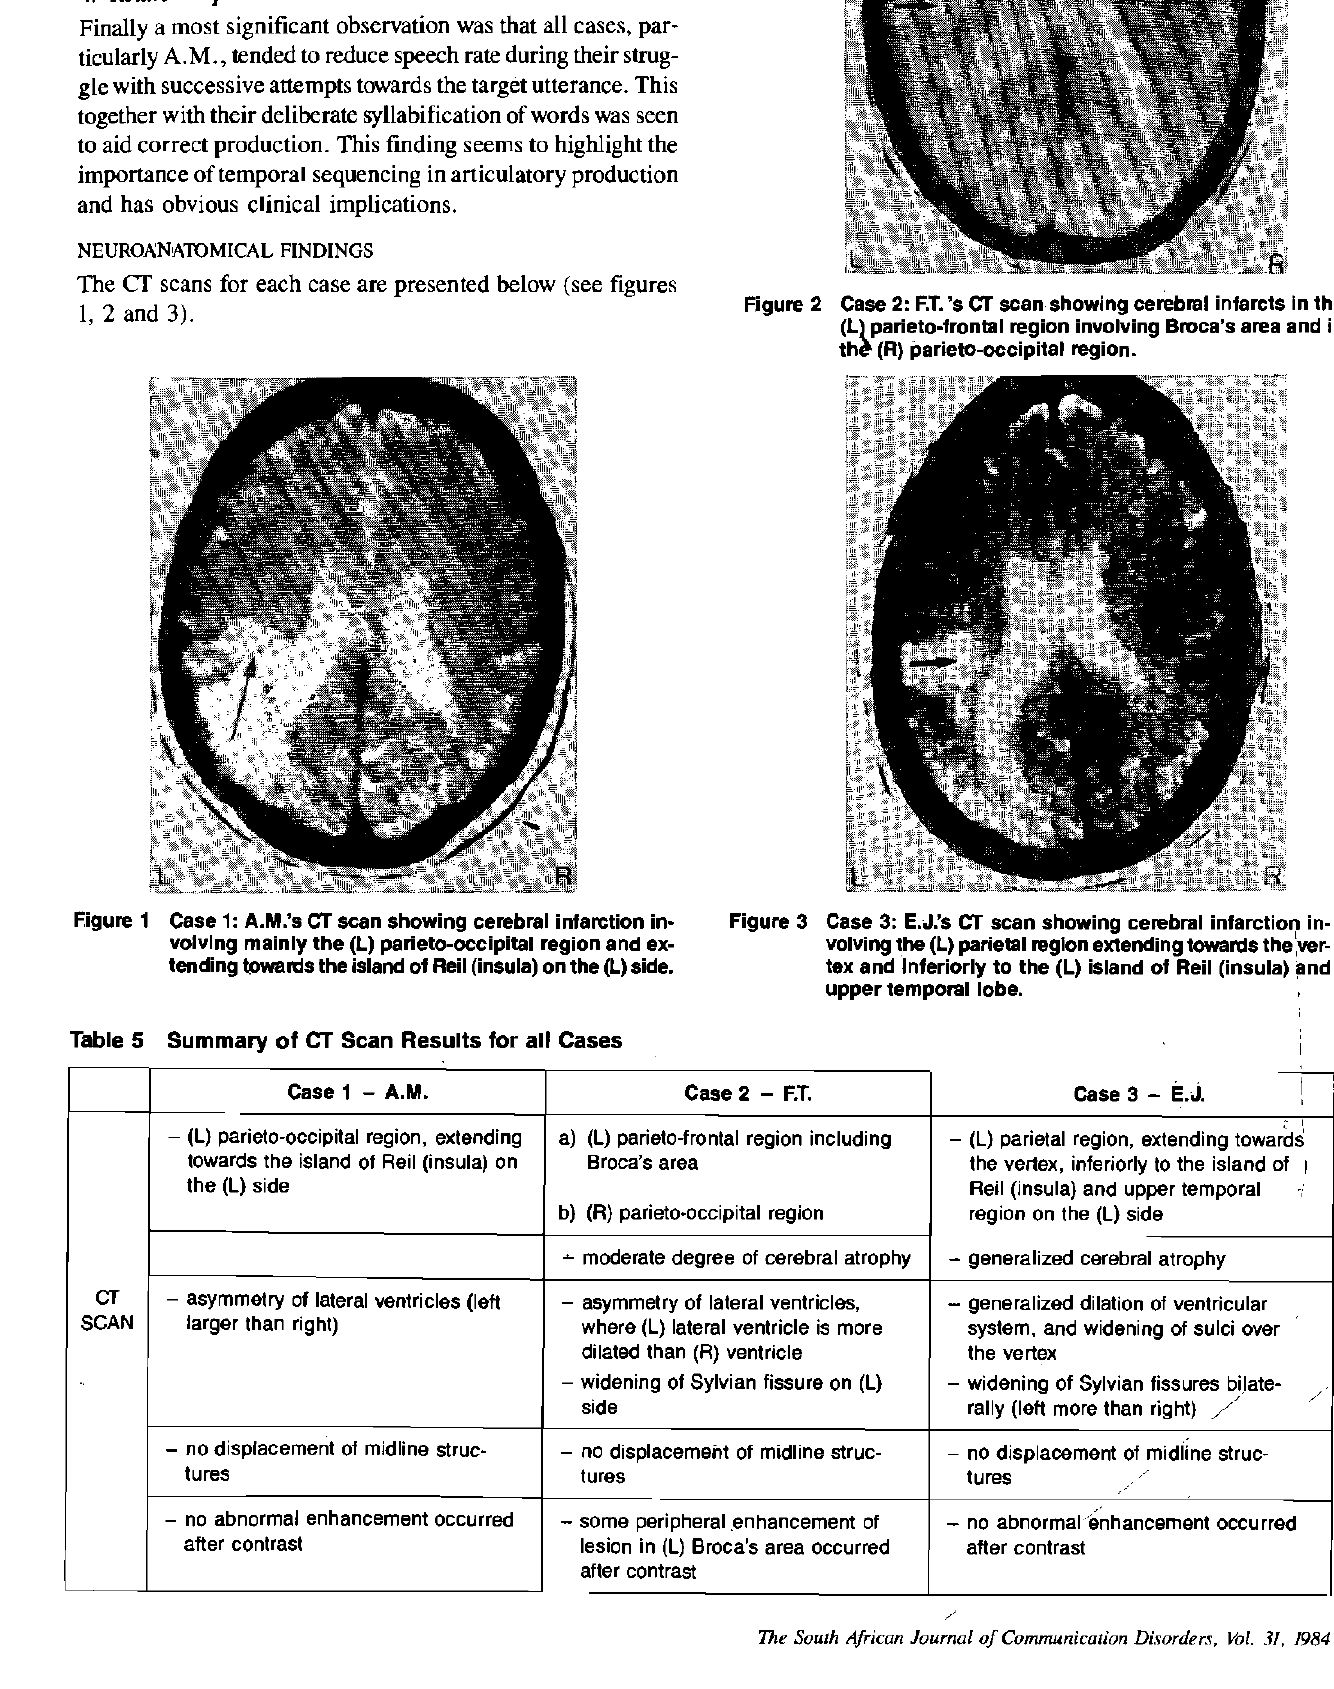
Figure 1 Case 1: A.M.'s CT scan showing cerebral infarction in- Figure 3 Case 3: E.J.'s CT scan showing cerebral infarction in- volving mainly the (L) parieto-occipital region and ex- volving the (L) parietal region extending towards the'ver- tending towards the island of Reil (insula) on the (L) side. tex and interiorly to the (L) island of Reil (insula) and upper temporal lobe. Table 5 Summary of CT Scan Results for all Cases Case 1 -